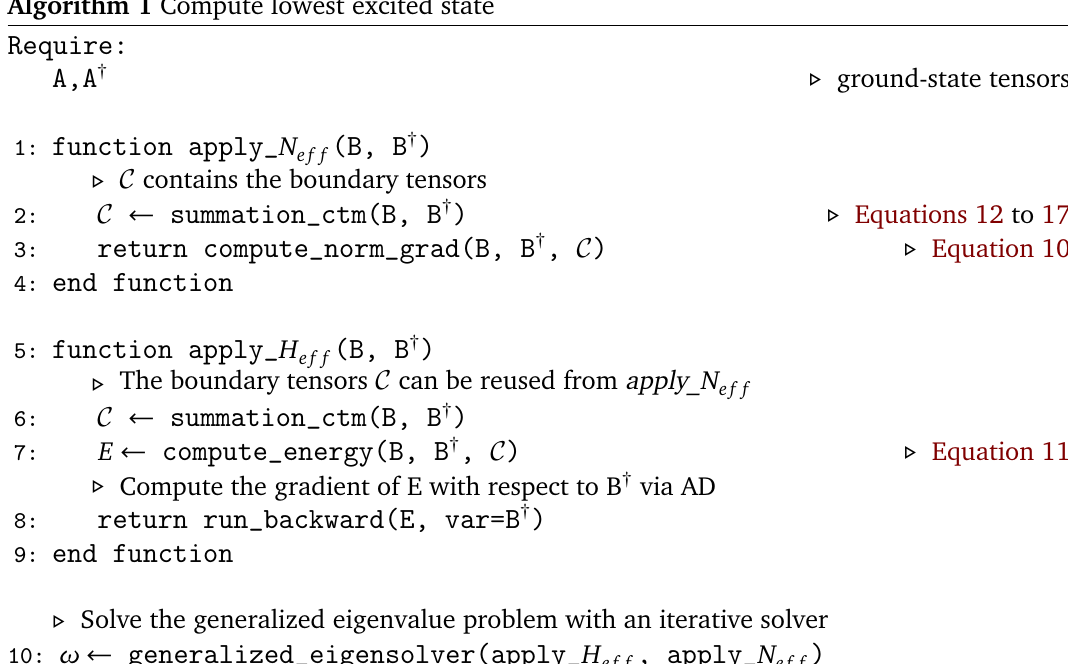
Algorithm 1 Compute lowest excited